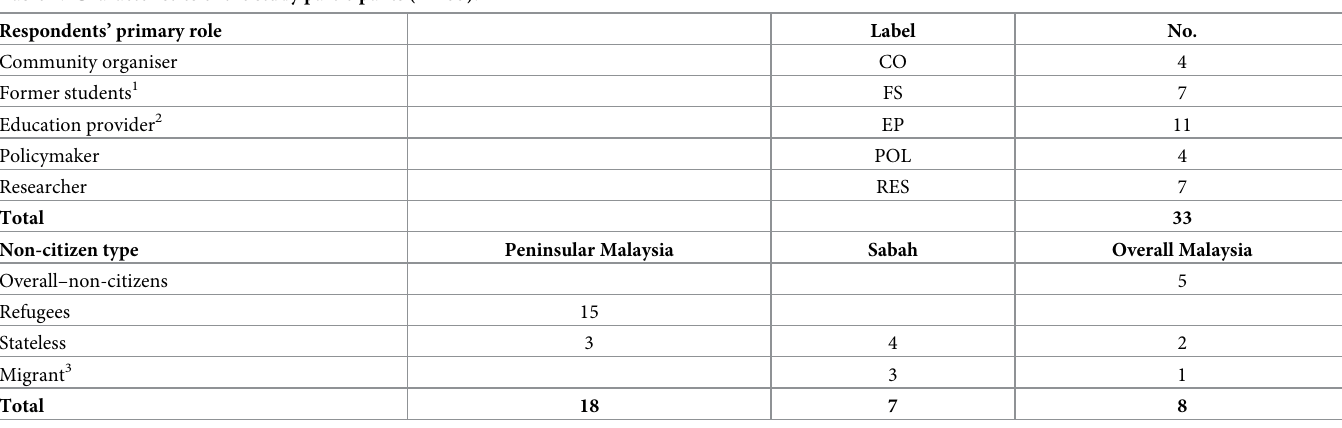
Table 1. Characteristics of the study participants (n =